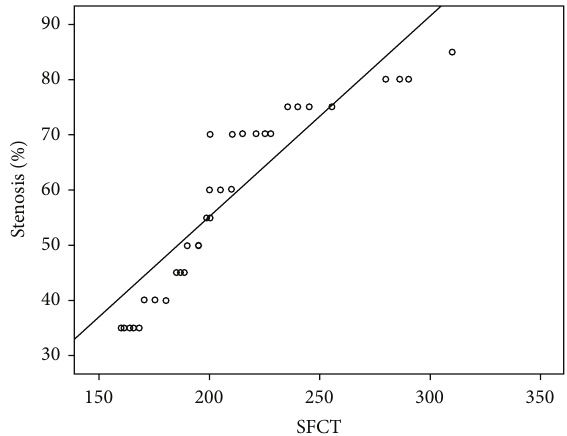
Figure 2: Scatter plot graph showing the relationship percentage of internal carotid artery stenosis and subfoveal choroidal thickness (SFCT). Table 3: Spearman rank correlation analyses between the subfoveal choroidal thickness and the percentage of ICA stenosis, IOP, and OPP. SFCT 𝑃 value Spearman rank